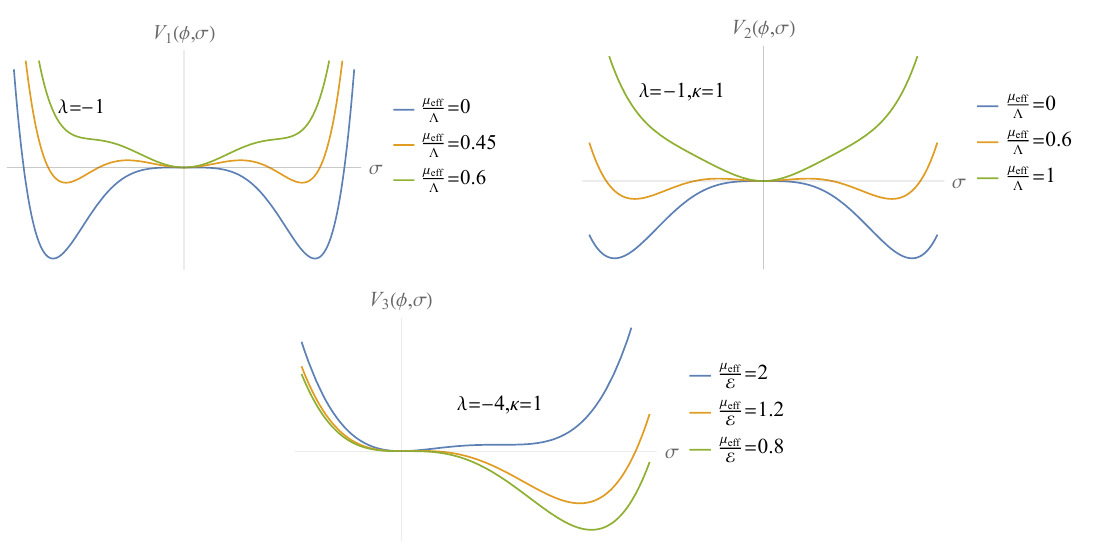
Figure 14 . This figure depicts the three typical potentials of the φ and σ field V 1 ( φ, σ ) , V 2 ( φ, σ ) and V 3 ( φ, σ )